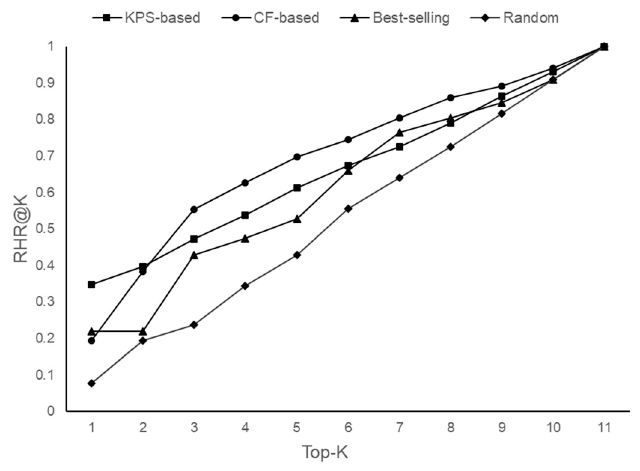
Figure 11. The performance evaluation of recommender systems for existing users.